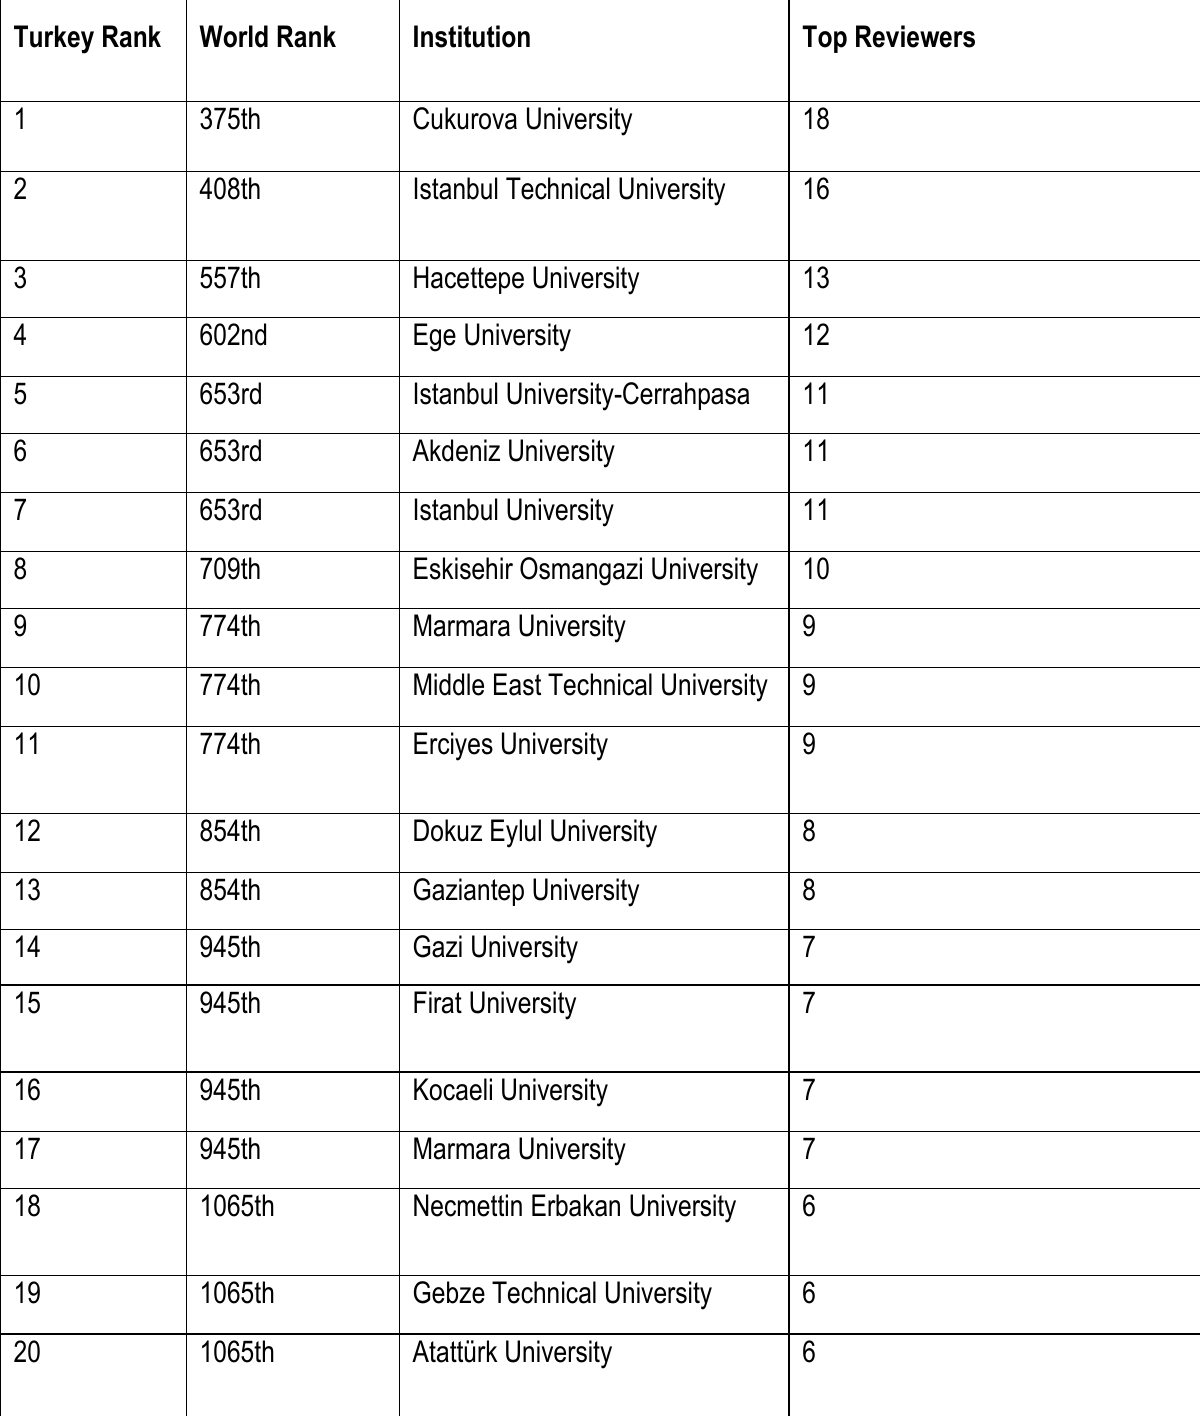
Table 6. Top 20 institutions in terms of the total number top reviewers Turkey